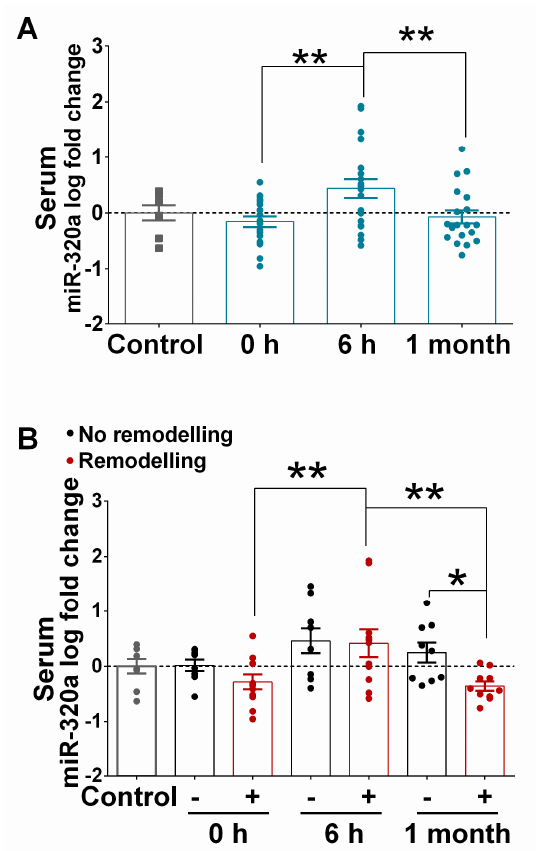
Figure 5. Comparison of the expression of miR-320a in the serum of patients with or without left ventricular adverse remodelling. ( A ) Bar graph shows miR-320a expression in serum samples of STEMI patients ( n = 20) at 0 h, 6 h and 1 month post PPCI relative to the control ( n = 8). ( B ) Bar graph shows the levels of miR-320a at 0 h, 6 h and 1 month after PPCI in STEMI patients who developed LVAR (red bar, n = 11) or not (black bar, n = 9). Values in the graphs represent the fold change in logarithmic scale for each miRNA relative to controls. Data are the means ± SEM. Significance is indicated by (*) for p < 0.05 and (**) for p < 0.01. Ordinary one-way ANOVA with multiples comparisons using T-test without correction (Fisher’s LSD test) was